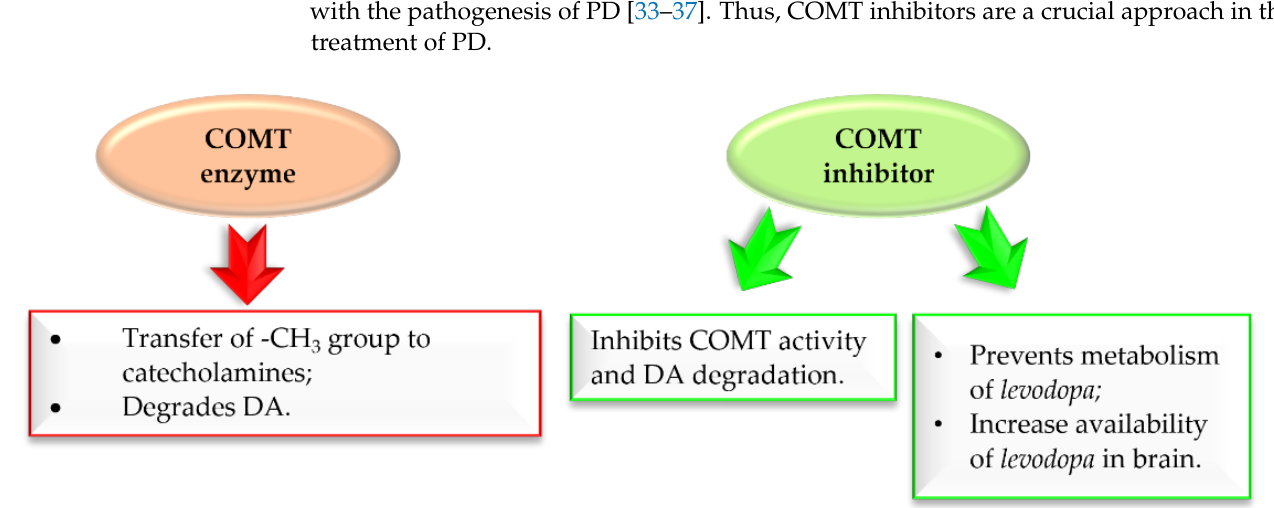
Figure 13. Action of COMT enzyme and COMT inhibitor in Parkinson’s disease .